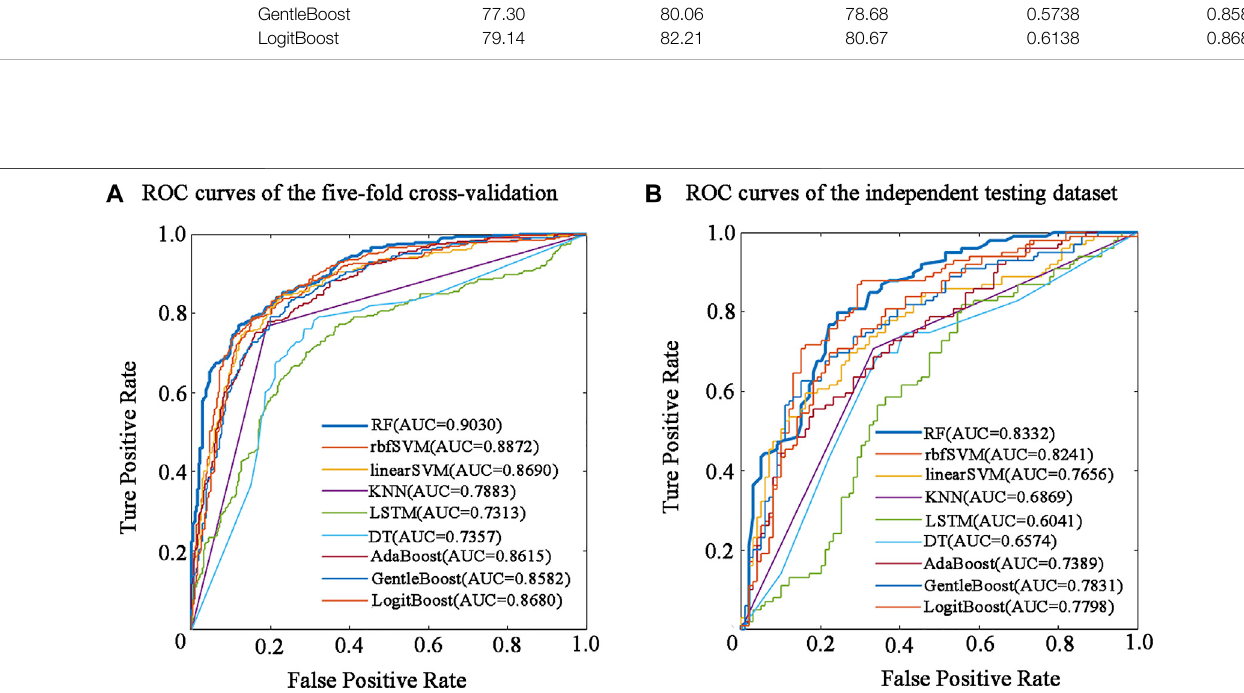
FIGURE 2 | Performance evaluation of different predictors in fi ve-fold cross-validation and independent testing dataset. (A) ROC curves of the fi ve-fold cross- validation. (B) ROC curves of the independent testing